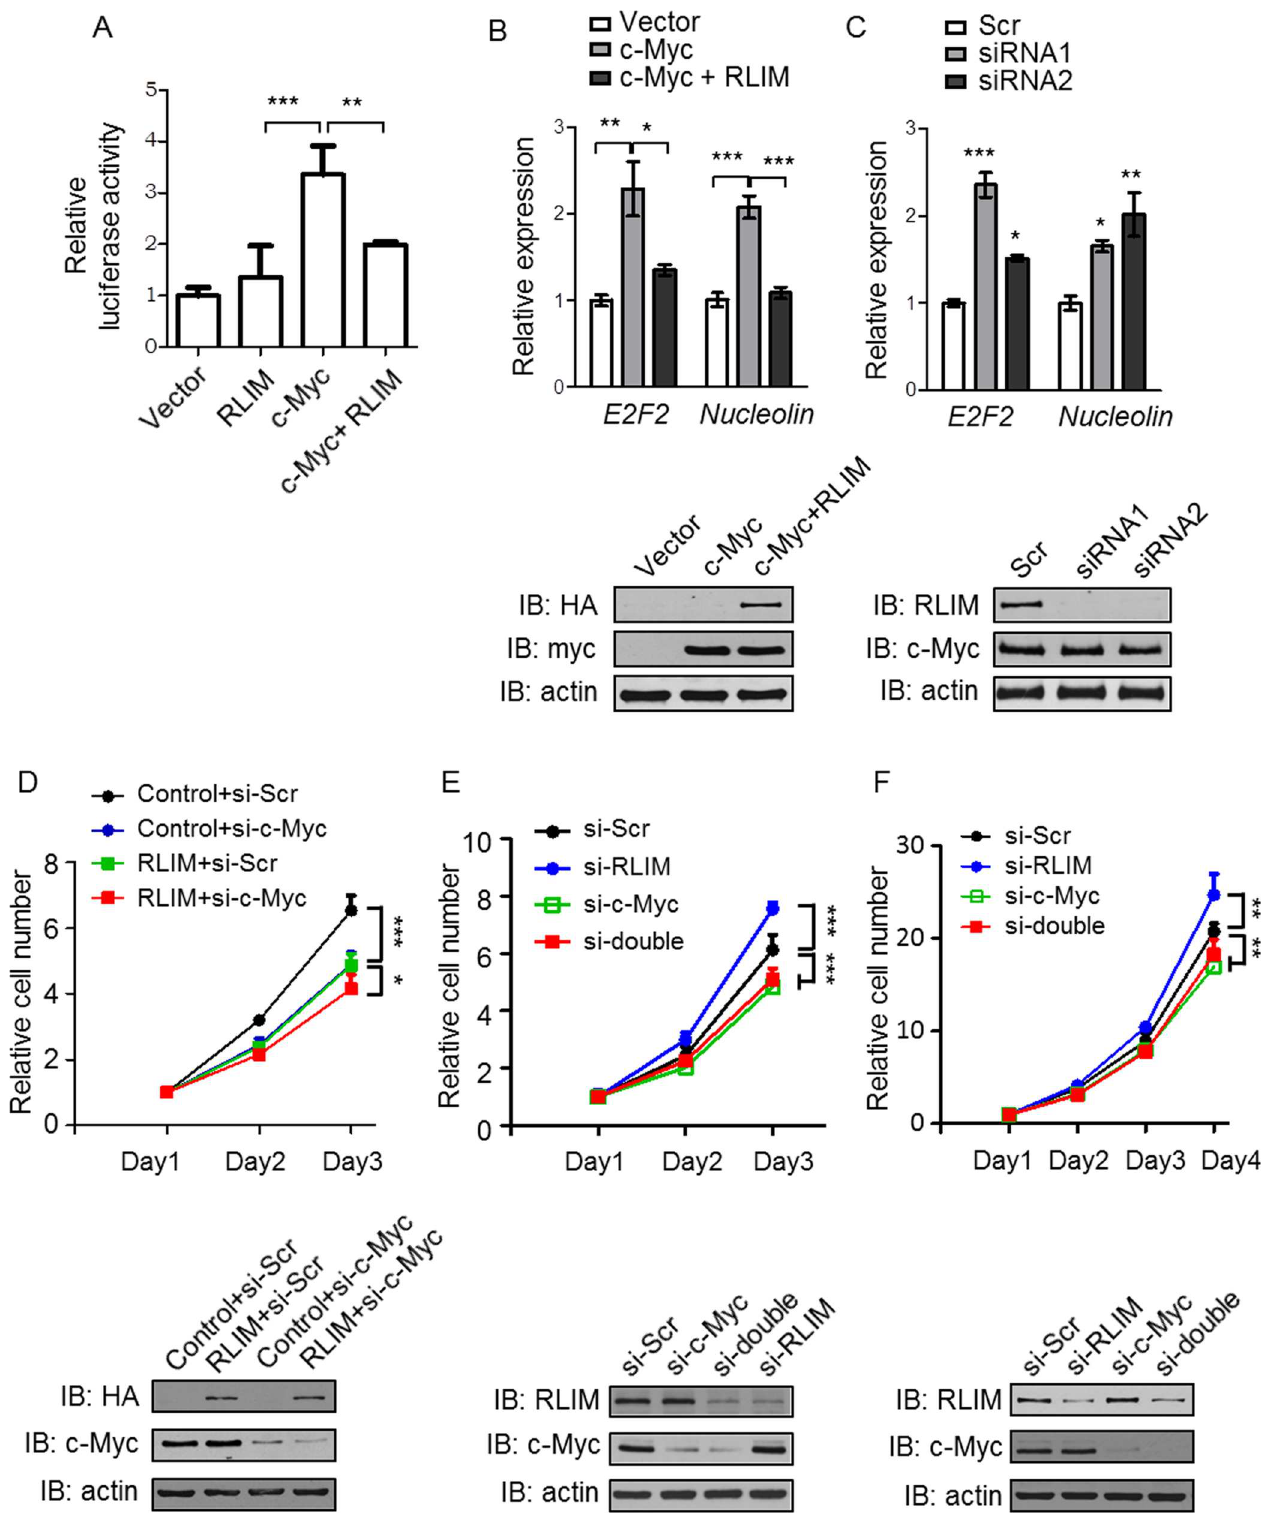
Fig 4. RLIM negatively regulates c-Myc transcriptional activity. (A) 293T cells were transfected with an E-box-luciferase (Firefly) reporter plasmid and a Renilla luciferase plasmid (as an internal control) together with c-Myc and RLIM plasmidsas indicated.Firefly